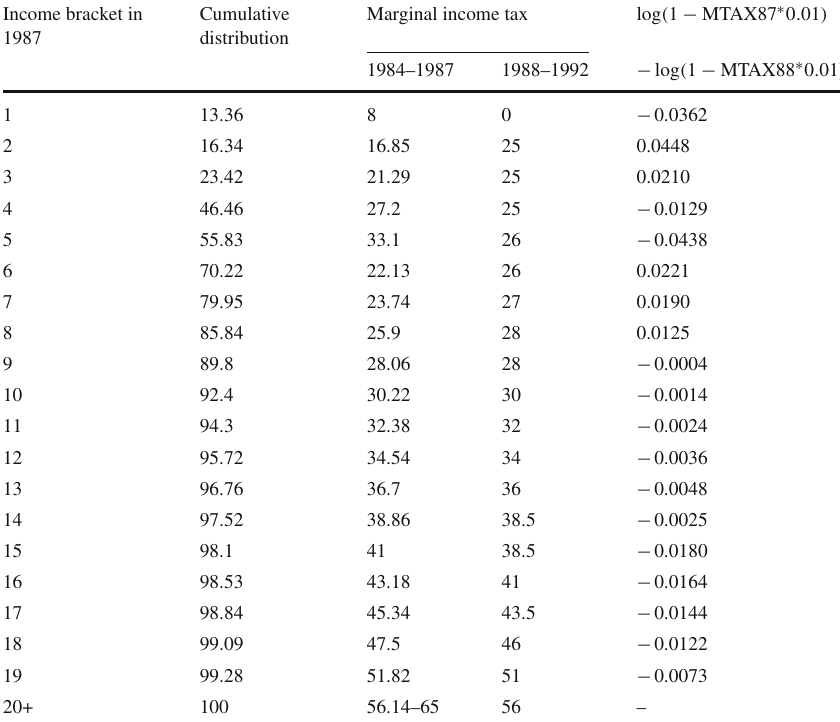
Table 9 The marginal income tax, by income bracket and the incentive to contribute to pension funds